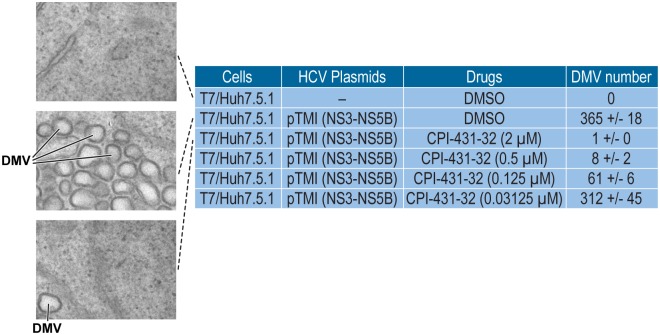
CPI-431-32 blocks HCV-mediated double-membrane vesicle (DMV) formation.T7 polymerase expressing Huh7.5.1 cells were transfected in triplicates with JFH-1 NS3-NS5B plasmid in the presence of DMSO or increasing concentrations of CPI-431-32 and analyzed by EM as well as by Image J and ITEM software for DMVs quantification as described previously [34]. Illustrating EM images of DMVs are presented with an amplification of 25,000x. Data are representative of two independent experiments.